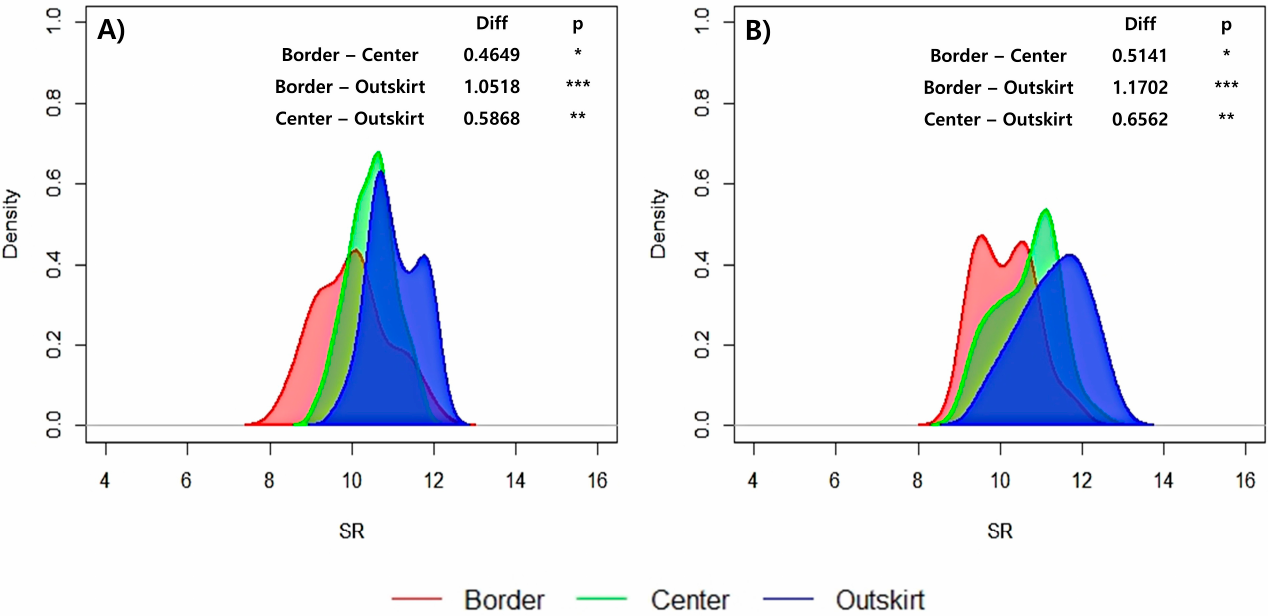
Figure 8. Density plots for the border detection effect in ( A ) 2018 and ( B ) 2019. (*, **, and *** indicate statistical significance among the lines at α = 0.05, 0.01, and 0.001, respectively).